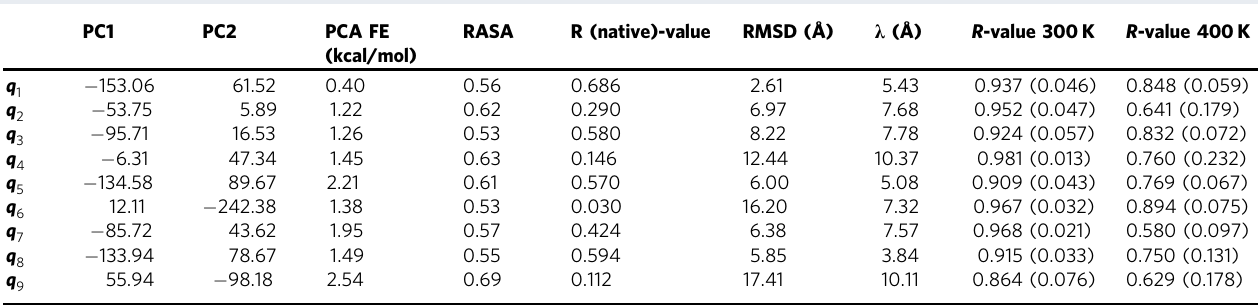
Table 2 Re fi ned binding con fi gurations produced by canonical MD simulations and stability estimation of r k using R-value analysis a . PC2 PCA FE (kcal/mol)